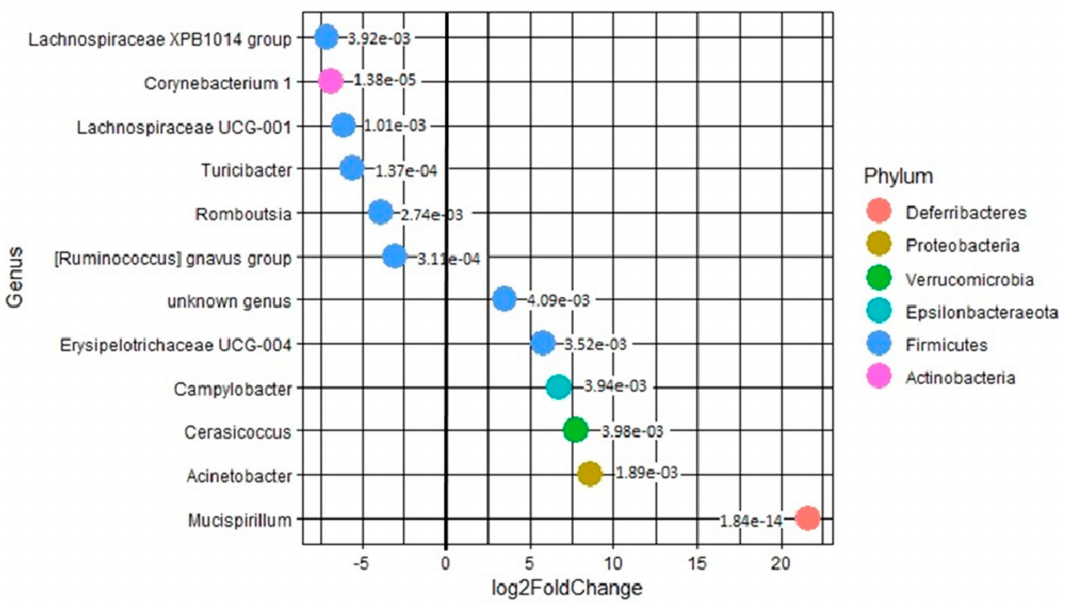
Figure 8. Di ff erentially abundant genera between proximal colon mucosal scrapping and proximal colon digesta. Only the statistically significant genera are represented ( p values are indicated on the